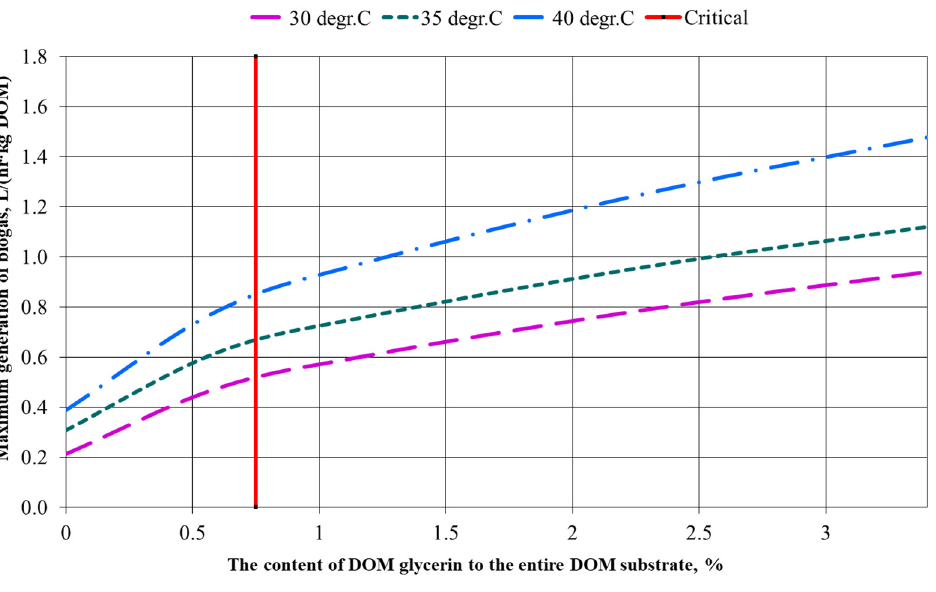
Figure 4. Simulated biogas yield during fermentation of cattle manure with the addition of crude glycerine for gradual loading of the digester. Table 3. Power function coefficients (Equation (13)) describing the simulated biogas yield during the fermentation of cattle manure with the addition of crude glycerine for gradual loading of the digester. Fermentation Temperature, ◦